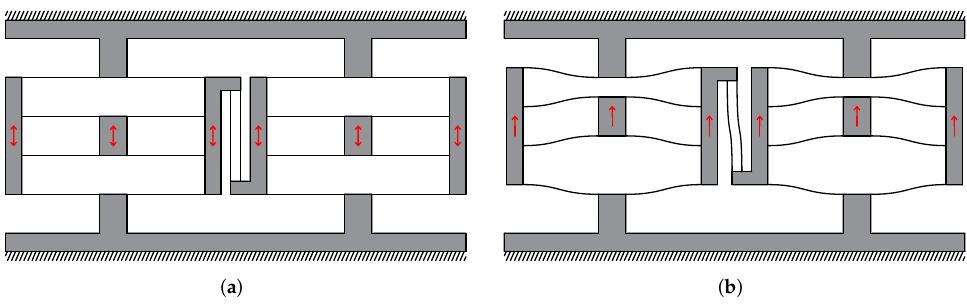
Figure 3. The in-parallel planar CDPMs connected by decoupling mechanism and its deformed shape. Figure 4a is the front view of the cylindrical compliant guide with three CDPMs.